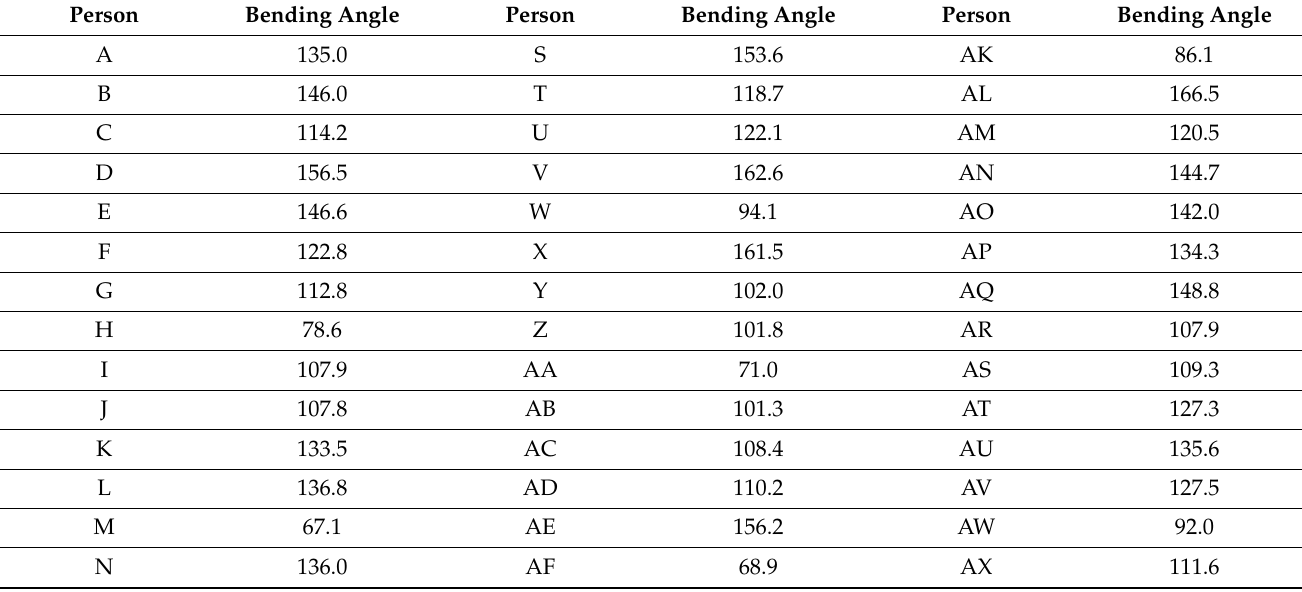
Figure 6. Angle measurement plot of basilar artery. ( a ) Person A; ( b ) Person (B); ( c ) Person C; ( d ) Person D (size). Table 1. Measurement of angle of basilar